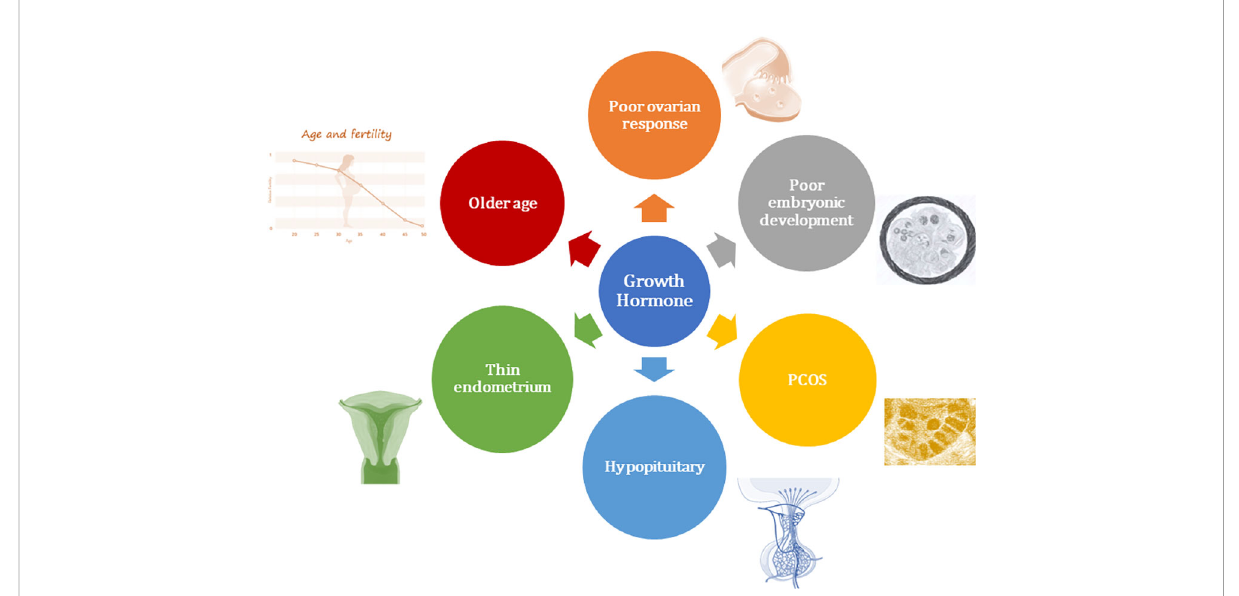
FIGURE 1 Overview of clinical application of growth hormone in women undergoing assisted reproductive